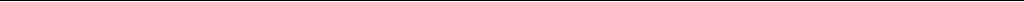
Fig. 4 Medio-apical myosin II accumulation and pulsatile changes in cell shape. a Merged confocal still frames from a time-lapse recording of a representative embryo ( N = 3) co-expressing CIBN::pmGFP (cell outline, in white), RhoGEF2::CRY2 (not visible), and the myosin II regulatory light chain reporter Sqh::mCherry in red (yellow arrowheads). Images are presented as maximum intensity projections (5 µ m) from the apical-most plane. Cells